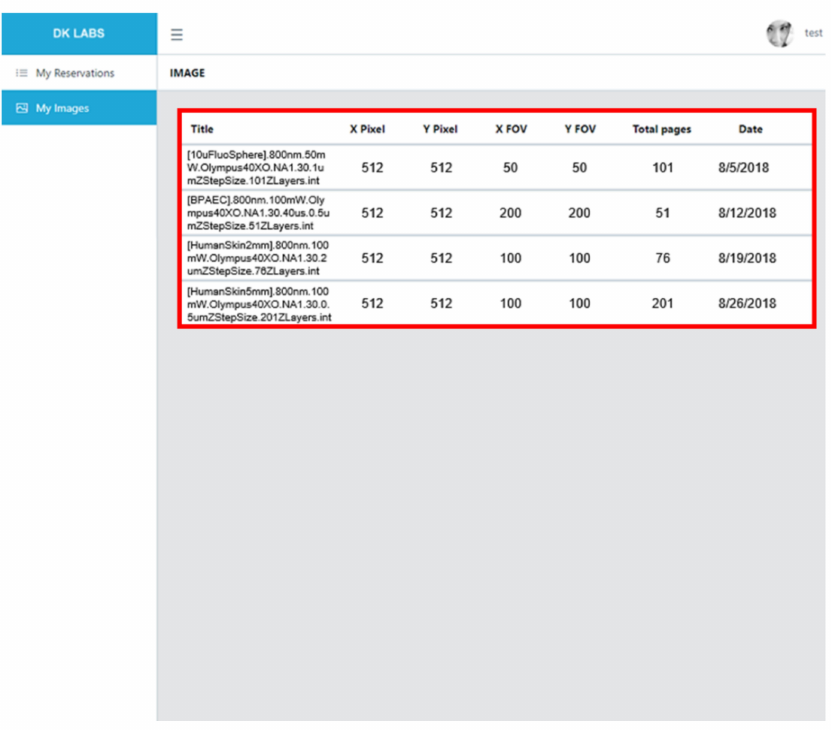
Figure A6. Theuserinterfaceofthedatalogpage.